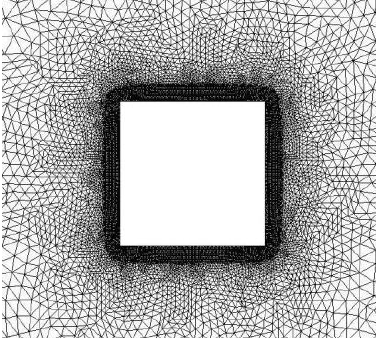
Figure 2. The unstructured mesh around the cylinder.